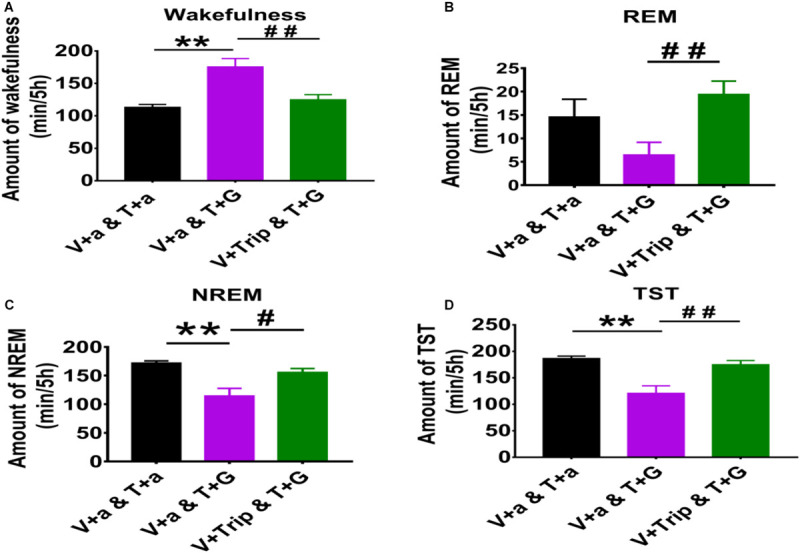
The sleep-wakefulness cycle was influenced by injecting L-Glu into TMN which could be blocked by injecting Trip into VLPO. (A) Top: Schematic drawing of the location of drug injection, or aCSF into the VLPO/TMN of a rat (Red: aCSF/Trip into VLPO, Yellow: aCSF/L-Glu into TMN). Bottom: Representative traces of EEG and EMG with drug injected. Drugs were applied at 10:00 (red line), and polysomnography recording started from 08:00 and lasted for 24 h. (B) Time-course changes of the sleep-wakefulness cycle in rat administration with L-Glu into TMN. (C) Time-course changes of the sleep-wakefulness cycle in rat administration with L-Glu into TMN and Trip into VLPO. Data were presented as mean ± SEM. The paired t-test was used in the statistical comparisons of two groups. *p < 0.05, **p < 0.01, ***p < 0.001 is compared between two groups at the same time. The arrow shows the time point of microinjection.